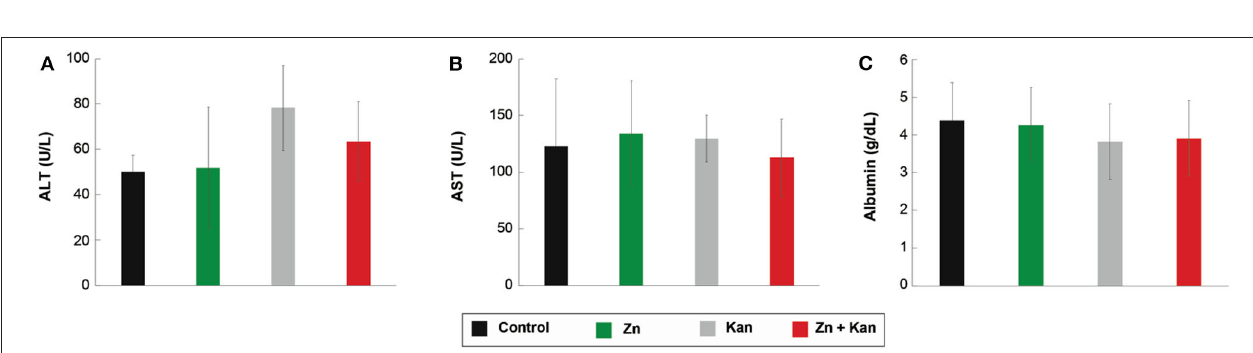
FIGURE 10 | Effect of Zn-kanamycin combination on the function of the liver in male Wistar rats. (A) ALT, (B) AST, and (C) Albumin levels. All experiments were tested in groups of n = 5 for 3 days. Error bars represent ± SD.